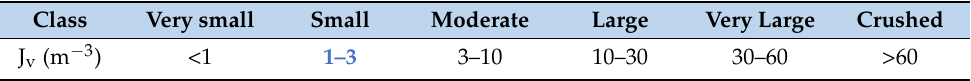
Table 4. Classification of degree of joint of rock mass according to the Volumetric Joint Count (Jv) [47].